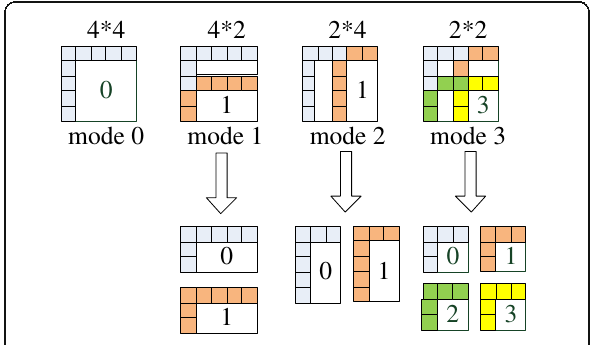
Fig. 5 Mode decision at the decoder with PB-based LVC (the number within each block indicates the coding